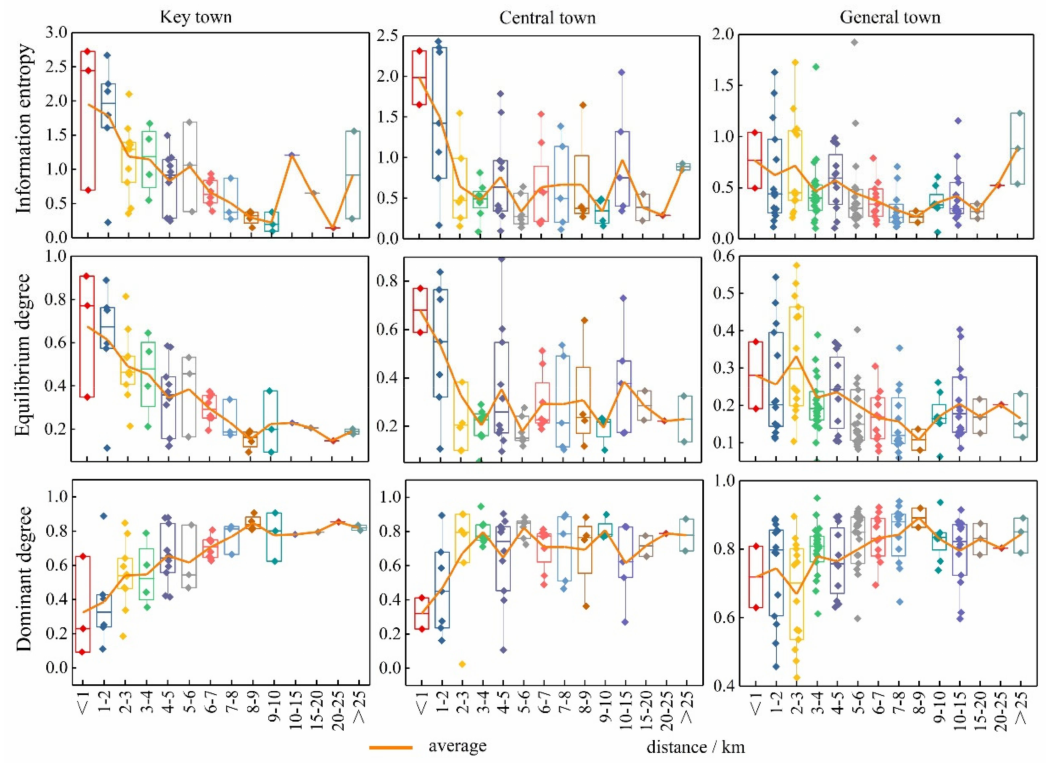
Figure 6. Township gradient differentiation of the quantitative structure of rural construction